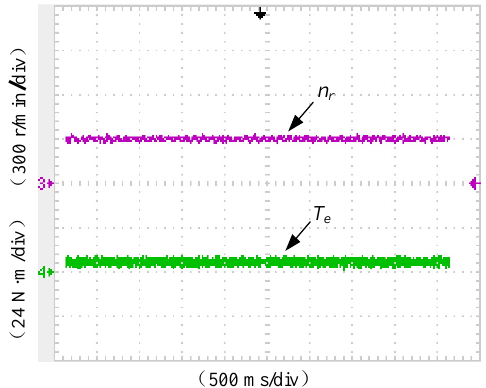
Figure 17. T e and n r of the MTFTSFPM machine under open-circuit fault using DTC.